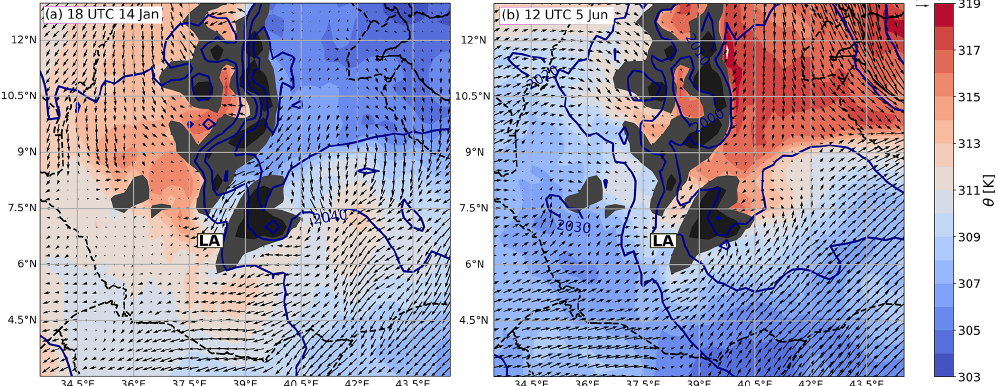
Figure 2. Potential temperature (colour contours, 1K increments), wind (arrows), and isohypses (i.e. lines of constant geopotential height; blue lines, 10m increments) at 800hPa in ERA5 over Ethiopia and Lake Abaya (LA) for (a) 18:00UTC 14 January 2020 and (b) 12:00UTC 5 June 2018. ERA5 model topography higher than 2000ma.m.s.l. is shaded in dark grey.